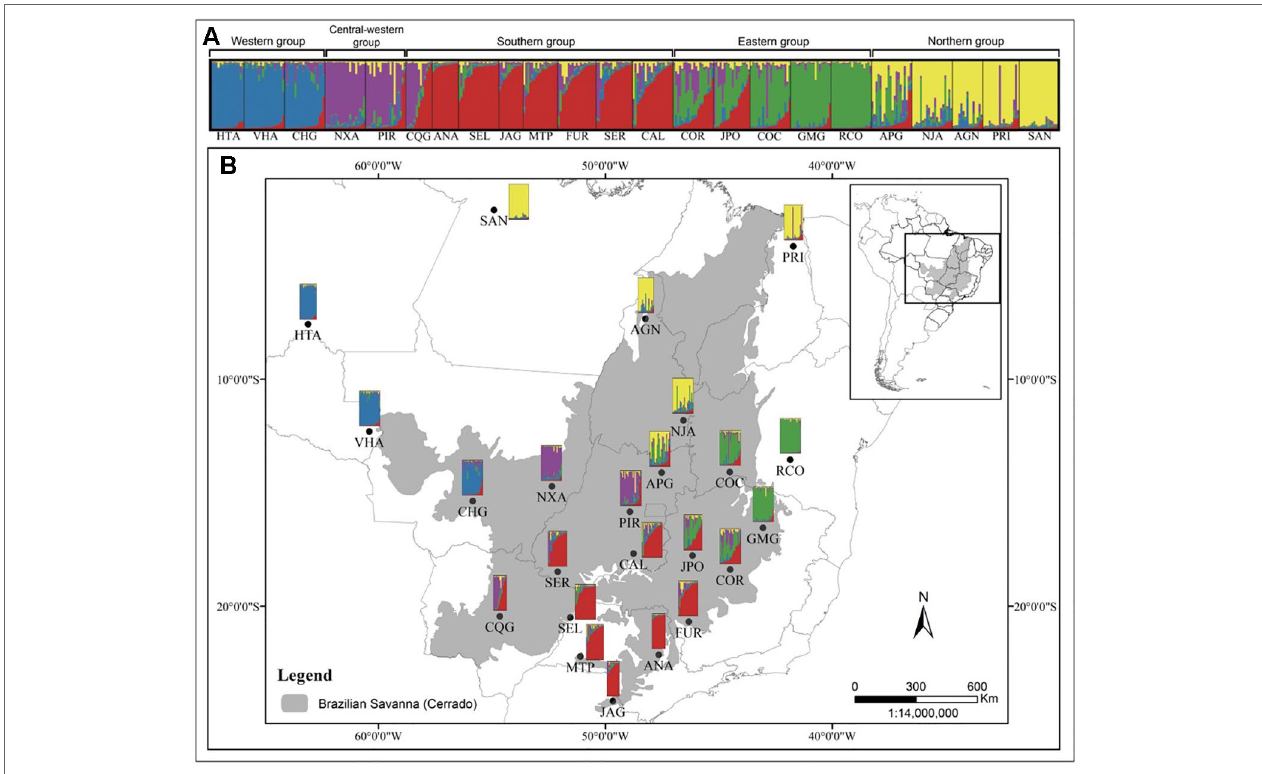
FiGUrE 1 | Barplot representation of the five genetic groups of Qualea grandiflora inferred by Bayesian analysis (STRUCTURE) of 418 individuals from 23 populations (A) . Map showing the sampled populations of Q. grandiflora and its population structure as determined by STRUCTURE (B) .